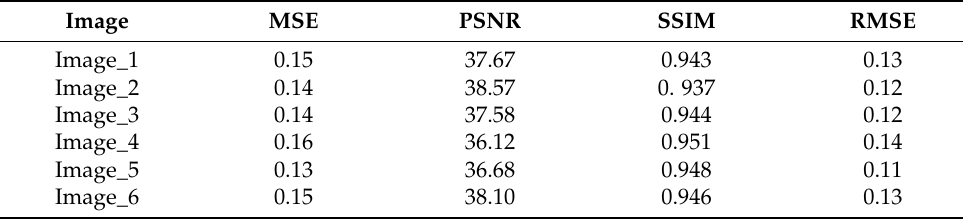
Table 1. MSE, PSNR, SSIM and RMSE for twenty